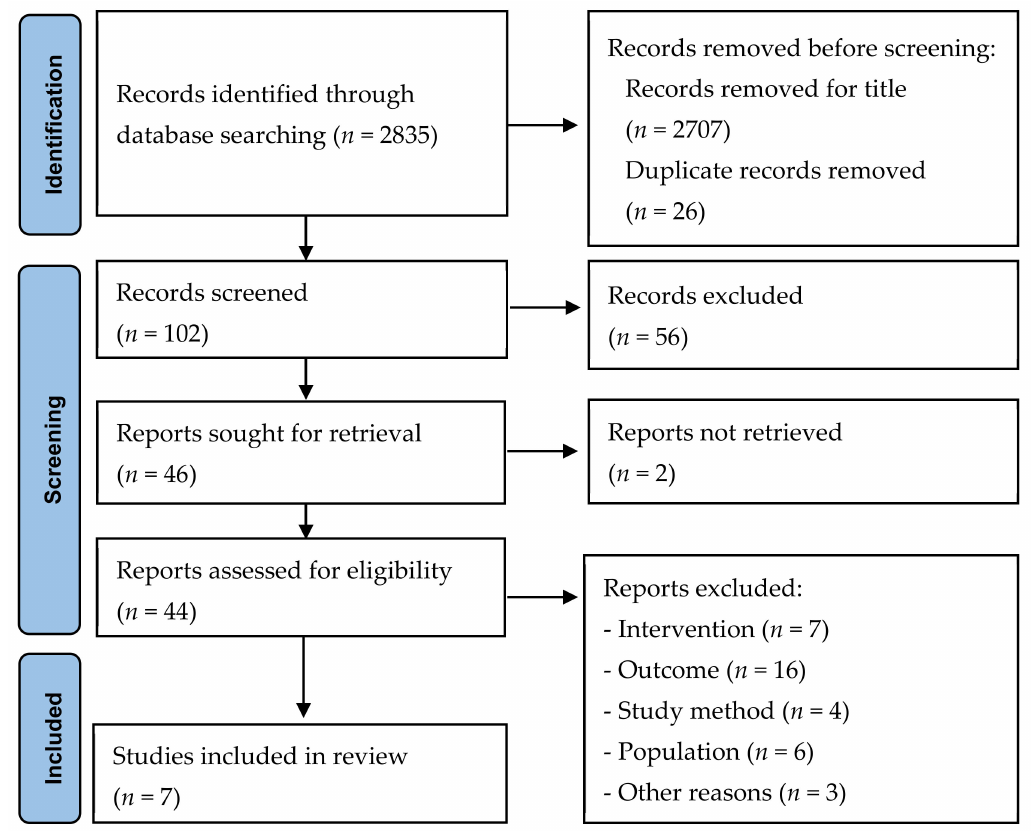
Figure 1. Flow diagram of study retrieval and